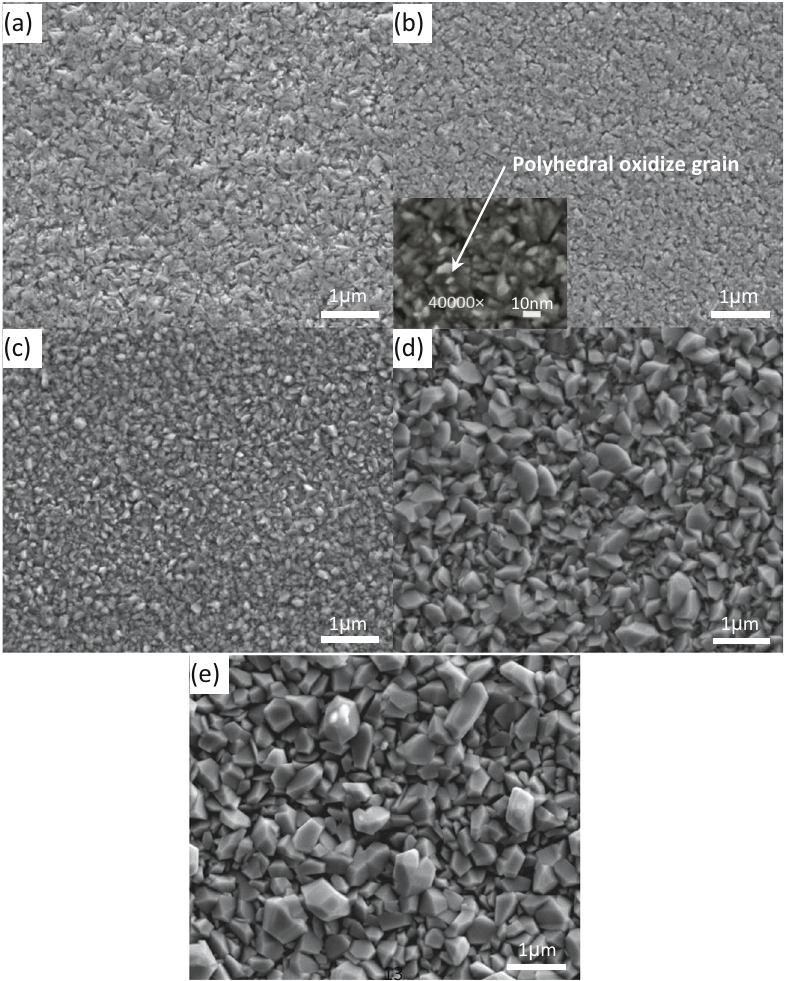
Figure 9: SEM surface micrograph of CrN coating B: ( a ) as deposited, ( b ) oxidized at 500°C, ( c ) oxidized at 600°C, ( d ) oxidized at 700°C and ( e ) oxidized at